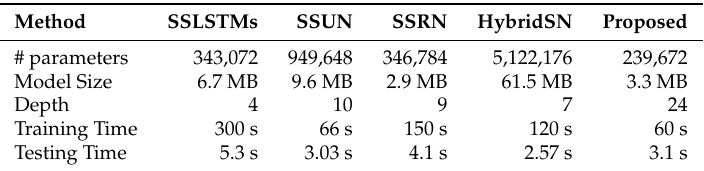
Table 12. Number of parameters, model size, depth, training time, and testing time on IP dataset on different methods with 10% training